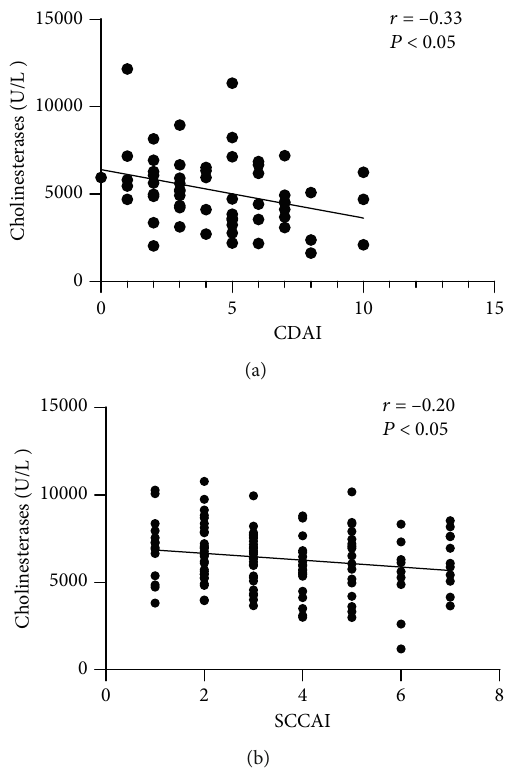
Figure 2: (a) The correlation between serum ChE levels and CDAI score in CD patients by using a scatter plot. (b) The correlation between serum ChE levels and SCCAI score in UC patients by using a scatter